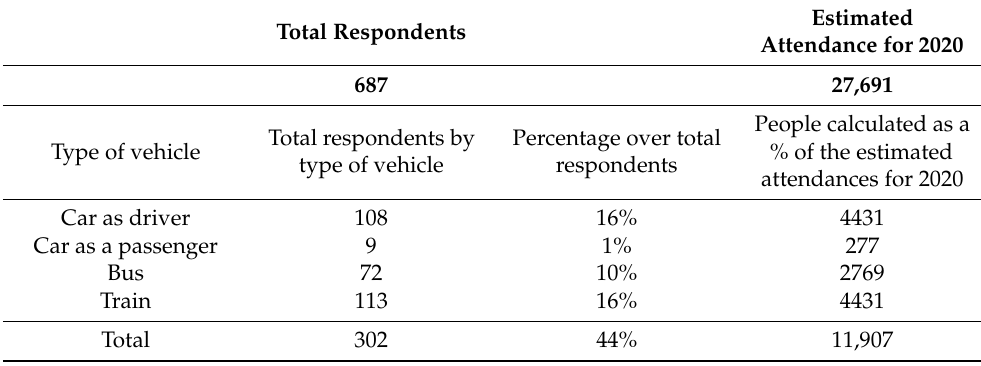
Table 11. Estimates of students using the different types of transport in